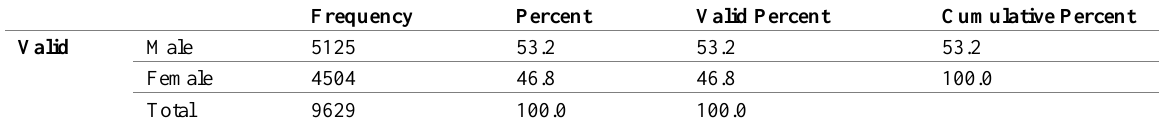
Table 3: Gender distribution in the sample